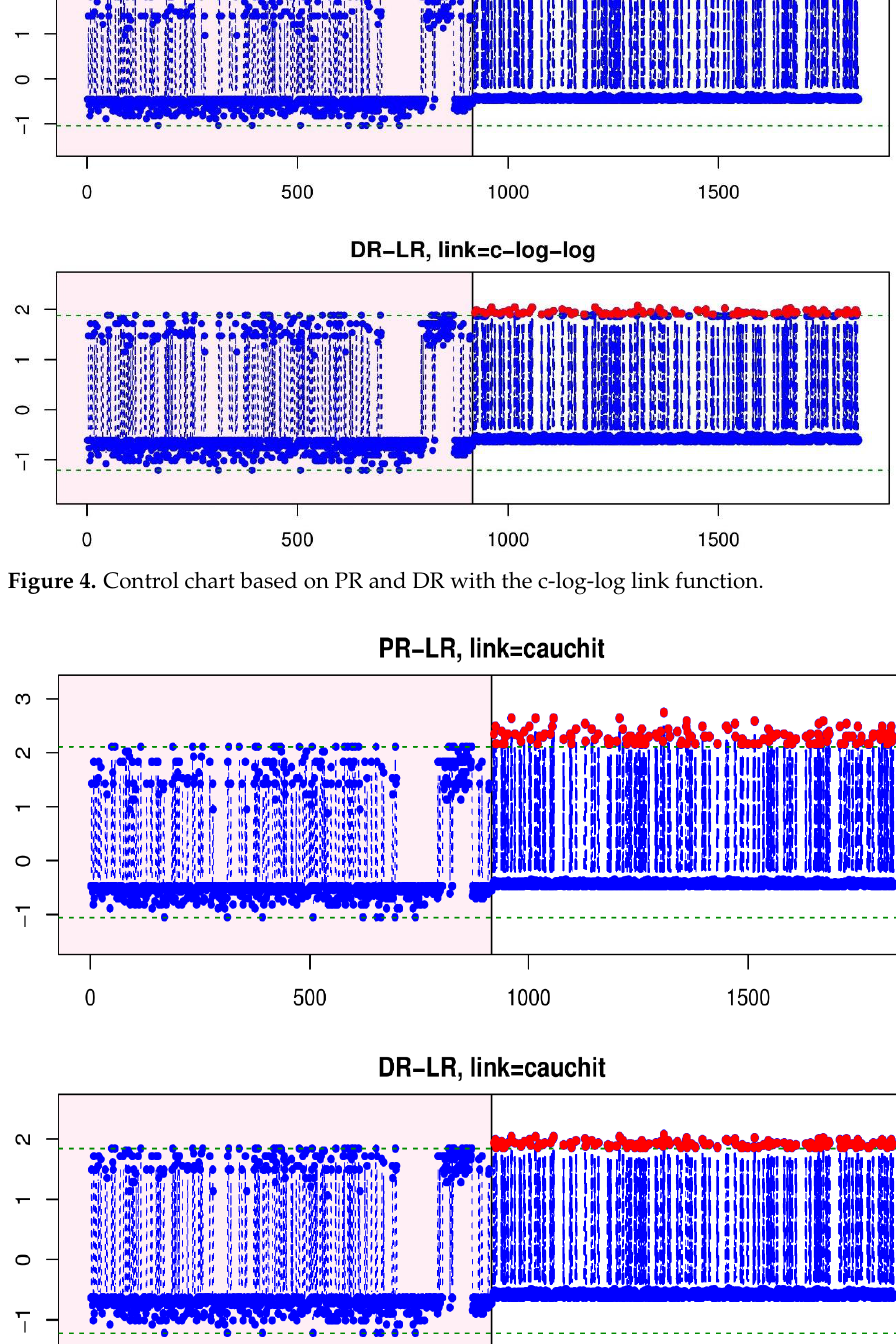
Figure 5. Control chart based on PR and Dr with the cauchit link function.